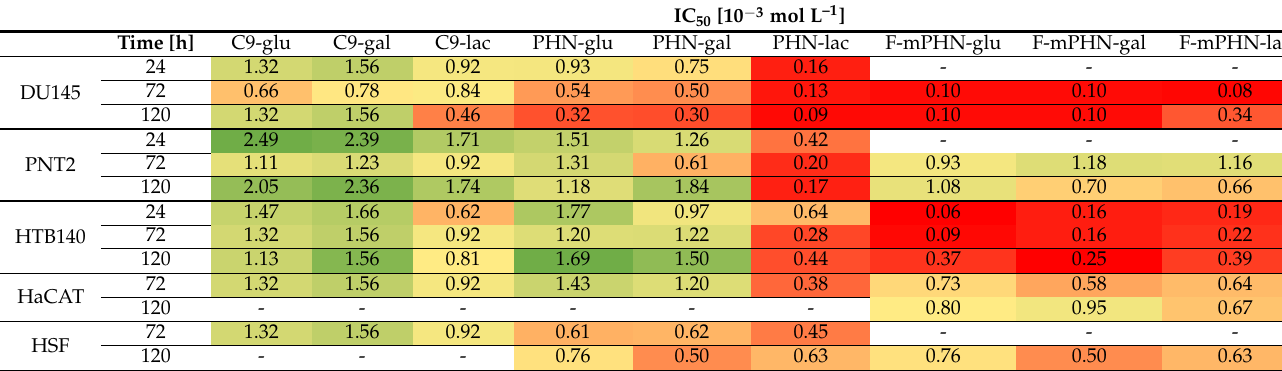
Table 2. Cytotoxicity IC 50 of SFAE determined by MTT